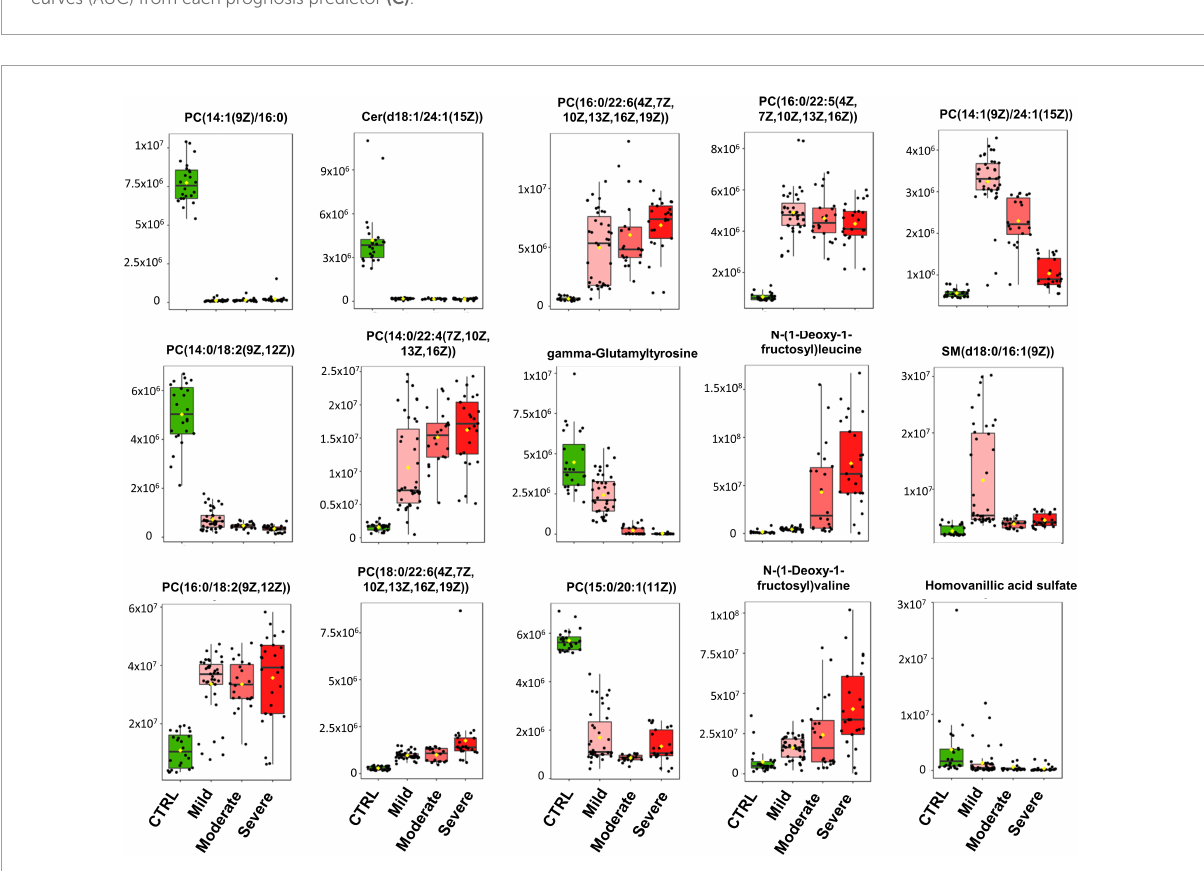
FIGURE2 Heatmap of the top 15 metabolites of SARS-CoV-2 infection. Metabolites were clustered using the ward method on t -test and ANOVA values. The molecular structures of the lipids are given.